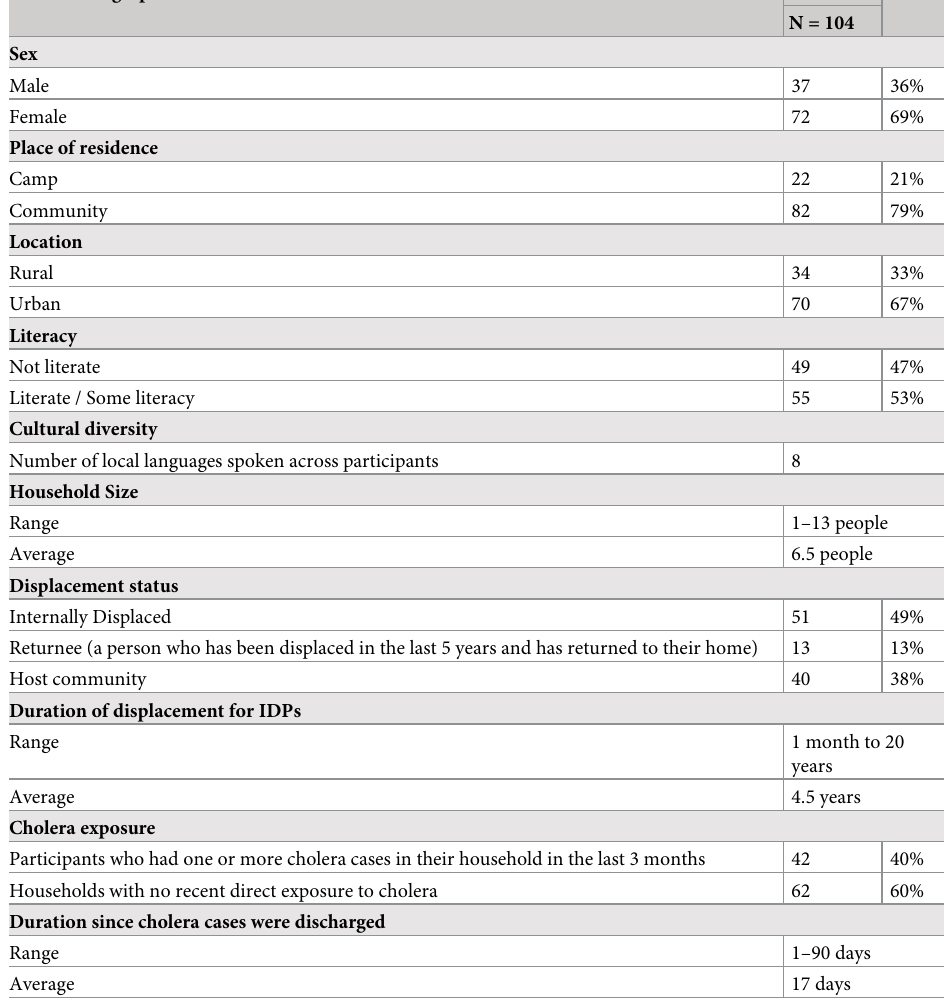
Table 1. Socio-demographic characteristics of all participants across the two camps and two villages. Socio-Demographic